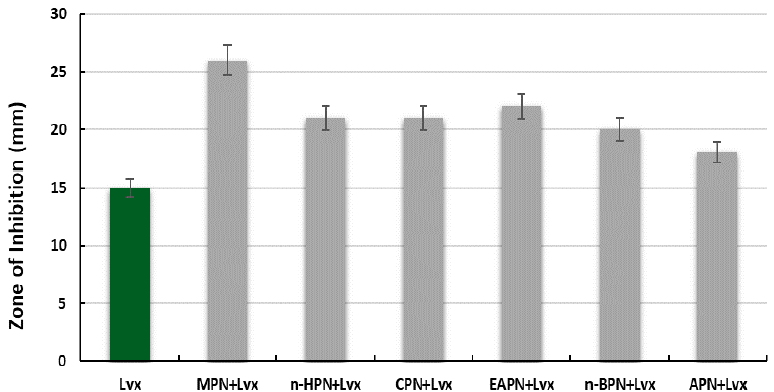
Figure 13. Antibiotic reversal activity of P. nigrum extracts in combination with levofloxacin (5 µ g) for S. typhi .